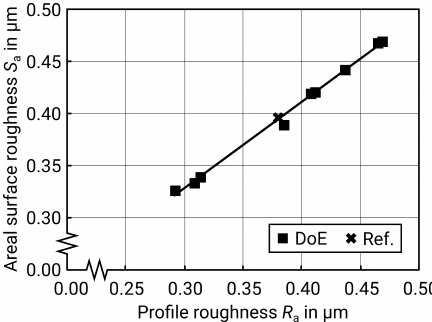
Figure 11. Linear regression of S a ( R a ) for vertical milled